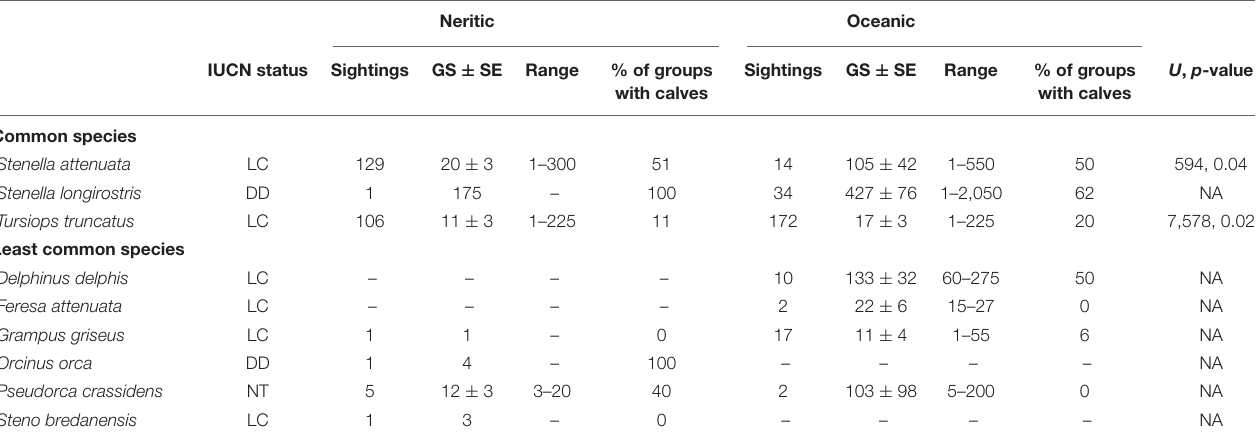
TABLE 2 | Summary of small cetacean species sighted of the Pacific waters of Guatemala including the number of sightings, mean and range of group size, percentage of groups with calves, and Mann–Whitney U test ( U ) results of group size comparisons between the neritic ( < 200 m depth) and oceanic ( > 200 m depth) zones. Neritic